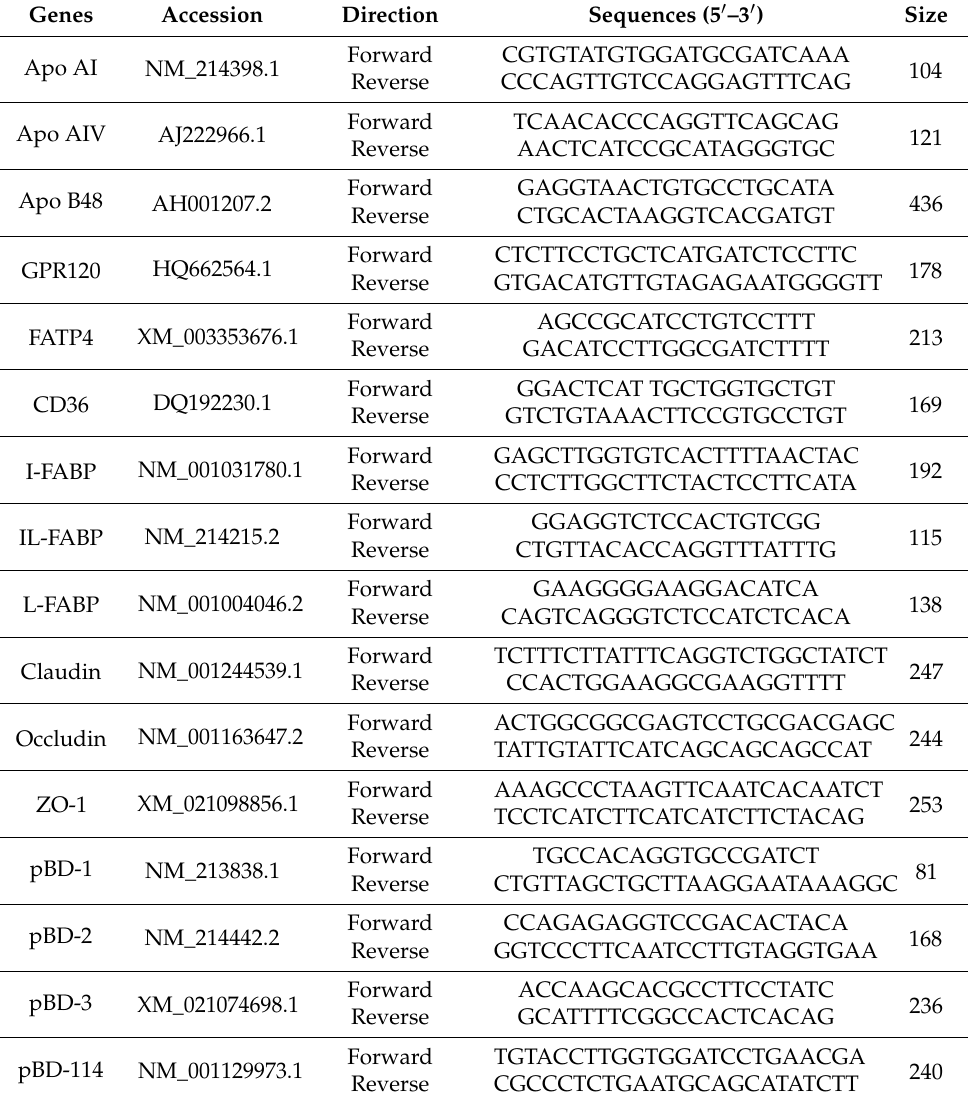
Table 1. Real-time PCR primer